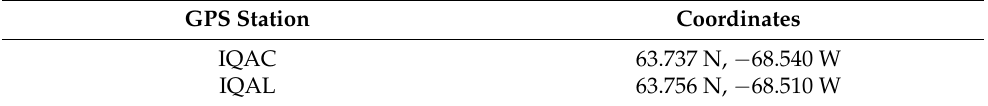
Table 3. GPS stations used for comparison.